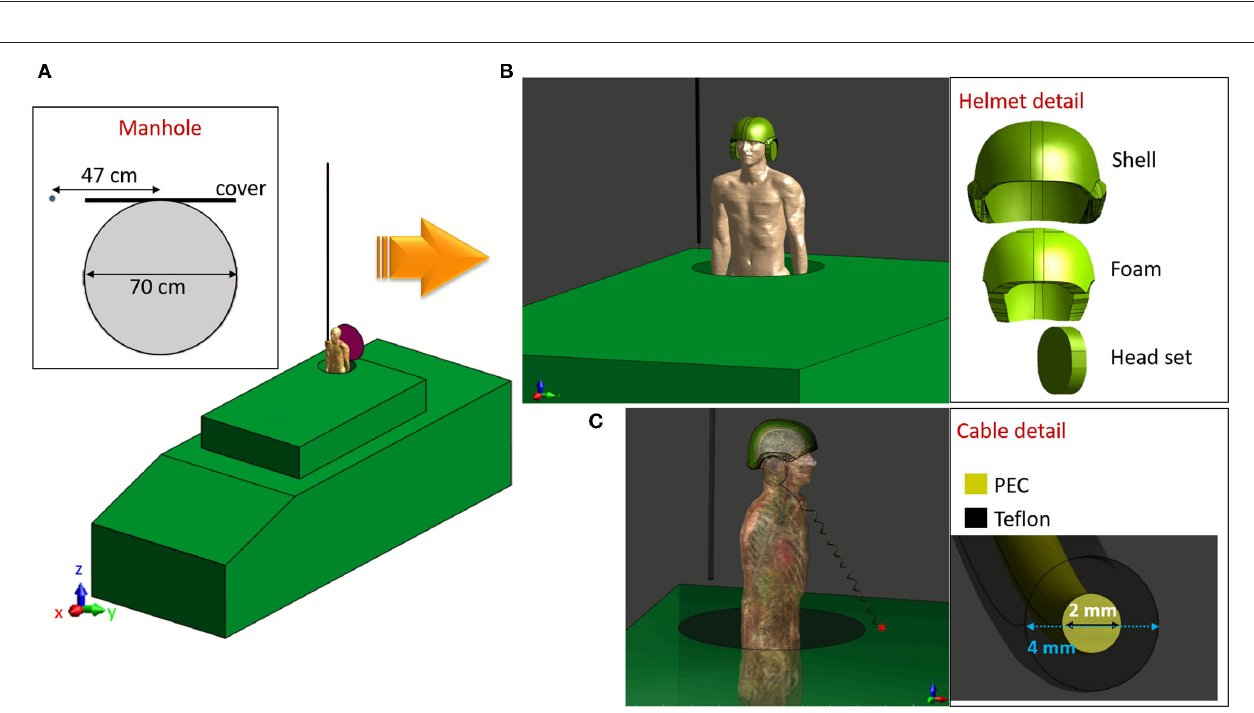
FIGURE 1 | Numerical model of the antenna. In the reference model, the monopole (4.25m high, diameter, 2a, of 4cm and feeding gap, b, of 5cm) is placed over an ideal infinite electric ground. In the realistic model, the monopole is mounted over a simplified 3D model of the vehicle, reproducing typical dimensions. A 60cm gap is considered between the bottom of the vehicle and the soil to simulate the presence of the tires.